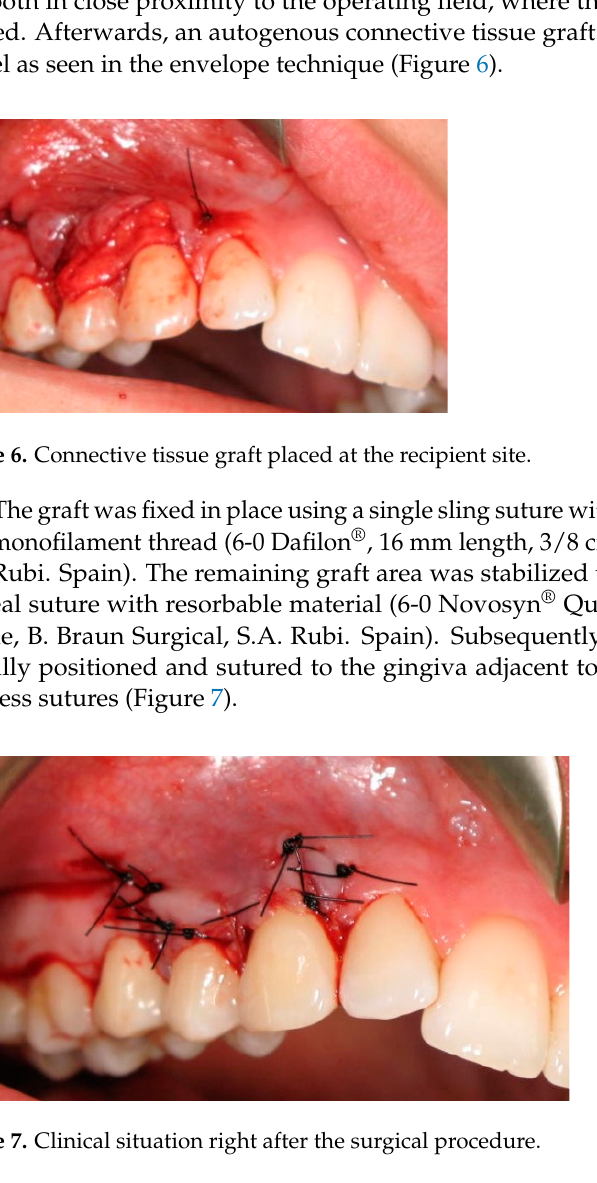
Figure 5. The split-thickness flap.